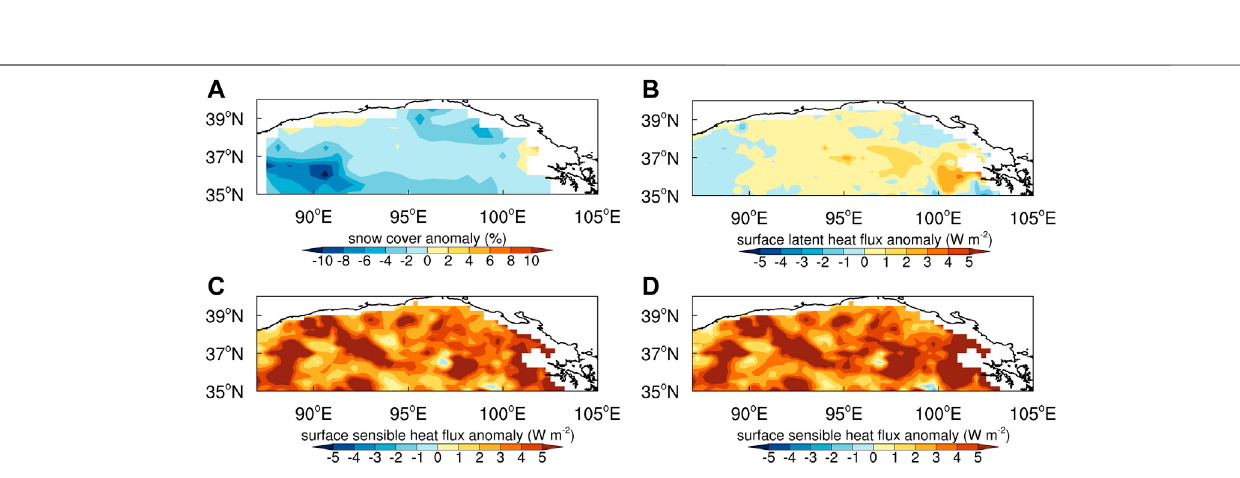
Frontiers in Environmental Science |